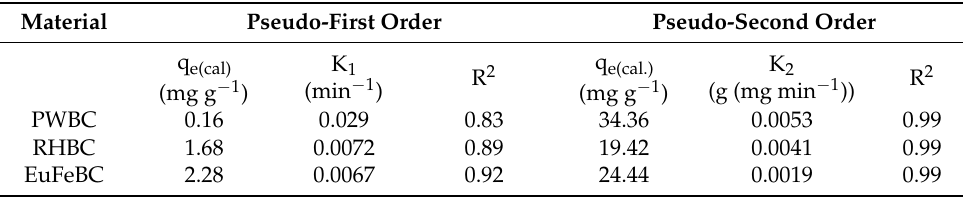
Table 2. Kinetic parameters for TCE on tested BCs.